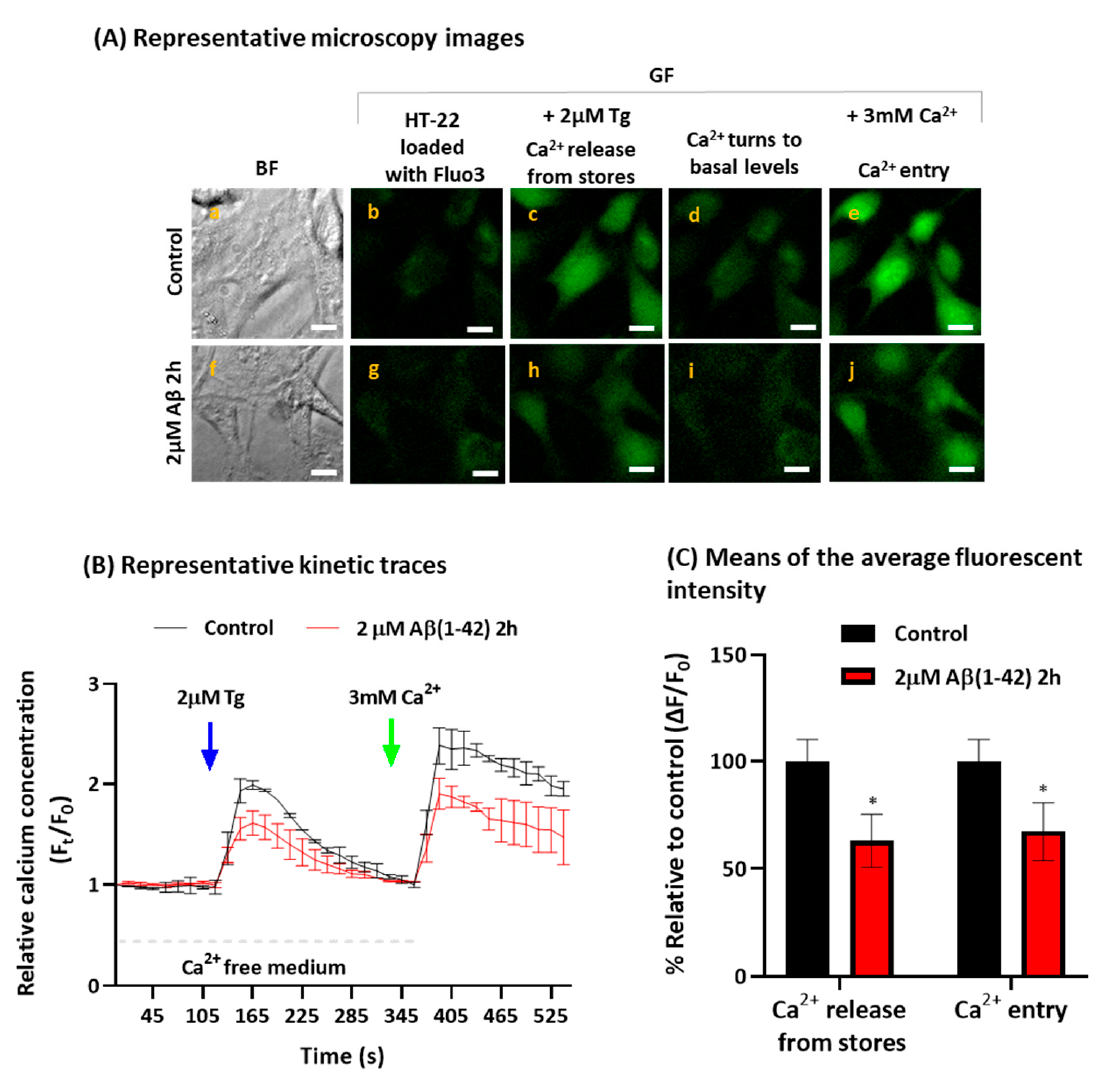
Figure 2. SOCE inhibition by A β (1-42) in HT-22 cells after 2 h of incubation. Untreated (control) and treated HT-22 cells incubated with 2 µ M A β (1-42) for 2 h at 37 ◦ C and 5% CO 2 were loaded with 5 µ M Fluo3-AM and 0.025% Pluronic ® F-127 for 1 h to experimentally evaluate Ca 2+ imaging of SOCE. Panel ( A ): representative microscopy images of Fluo3-loaded untreated HT-22 (control) and cells treated with 2 µ M A β (1-42) 2 h, acquired during SOCE experiments. (a,f) Bright field images (BF) of the fields selected for fluorescence images of Fluo3-loaded cells obtained before addition of 2 µ M Tg (b,g), at the peak fluorescence after the addition of Tg (c,h), after completion of the Ca 2+ release from the ER (d,i), and at the peak fluorescence after the addition of 3 mM Ca 2+ (e,j). Scale bar = 20 µ m. Panel ( B ): representative kinetic traces of untreated HT-22 cells (black trace) and HT-22 cells incubated with 2 µ M A β (1-42) for 2 h (red trace) after the addition of 2 µ M Tg (indicated by the blue arrow) for Ca 2+ release from stores and after addition of 3 mM Ca 2+ to evaluate the extension of Ca 2+ entry in HT-22 cells through the plasma membrane (indicated by the green arrow). Panel ( C ): means of the average fluorescent intensity ( ∆ F/F 0 ) relatively to control, after addition of Tg (Ca 2+ release from stores) or after addition of Ca 2+ (Ca 2+ entry). Results show that A β (1-42) inhibits 37 ± 7% and 32 ± 6% of Ca 2+ release from stores and Ca 2+ entry, respectively, compared with control. Data are presented as the mean ± SEM of experiments done at least in 10 Petri plates in 5 independent assays (n > 80 cells, * p < 0.05, relatively to each